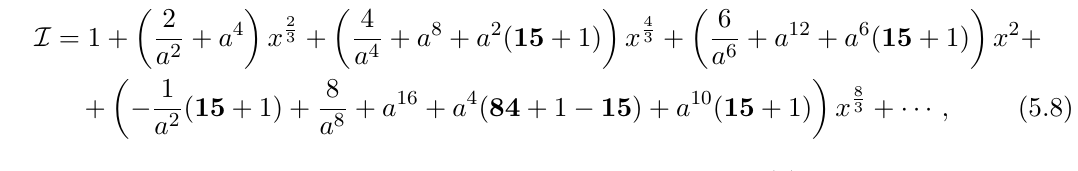
Figure 16 . The theory we get when gluing the tube in figure 1 to itself. Here we shall take k = 6 − N f . Besides the flipping superpotential, there is also a cubic one involving the adjoint and 2 two fundamentals. This breaks the symmetry in the square to SO( N f )